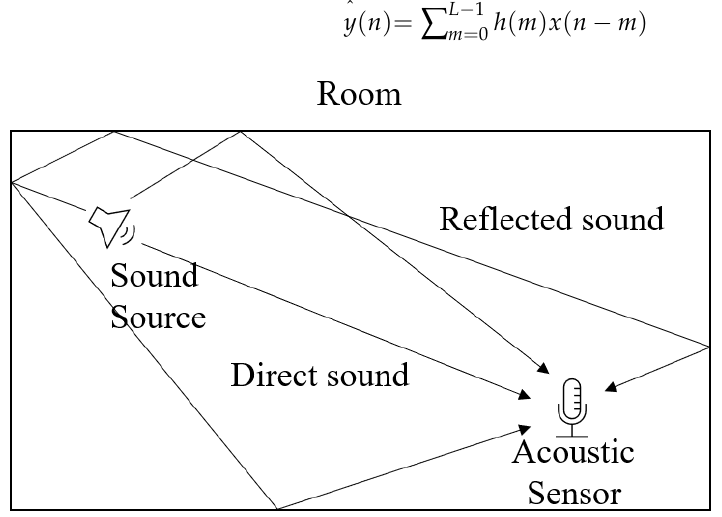
Figure 1. Example of acoustic transmission in a room.